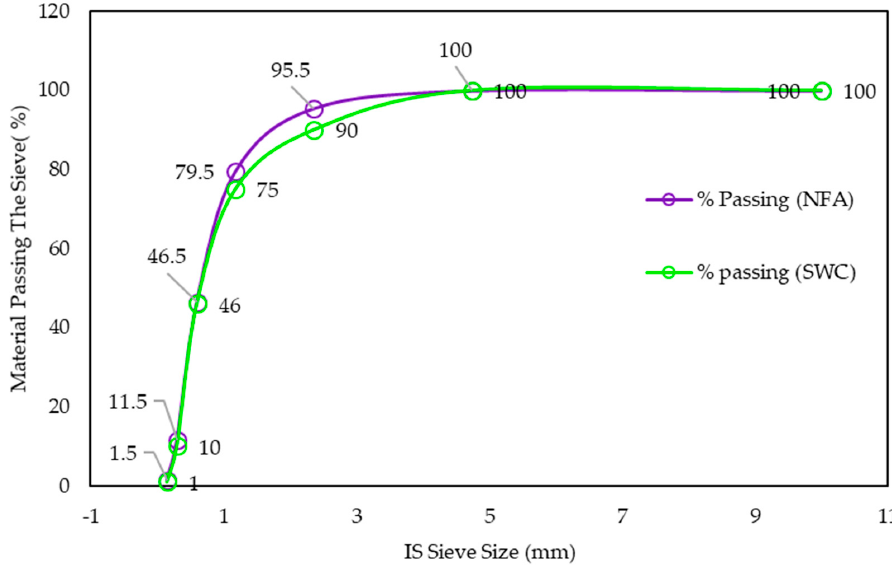
Figure 2. Particle size distribution of natural fine aggregate and ceramic fine aggregate.